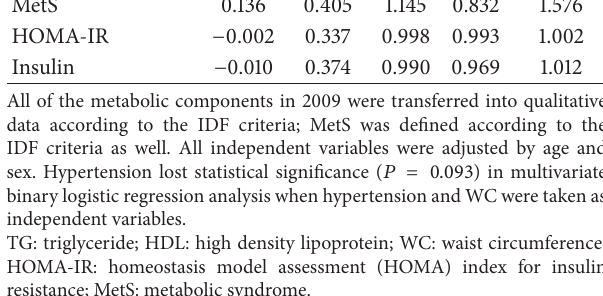
Table 4: Multivariate binary logistic regression analysis: dependent variableisthyroidnodulein2012,andindependentvariablesareage, sex,andthe 𝐷 valuesofSBP,DBP,WC,FBG,TG,andHDL(method: forward stepwise LR or backward stepwise LR). 𝛽 P value 95% C.I. for RR